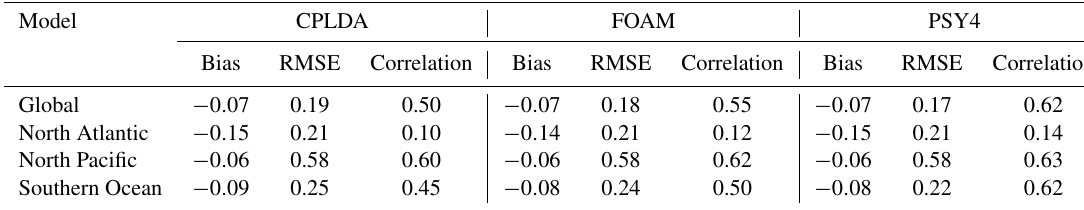
Southern Ocean − 0 .